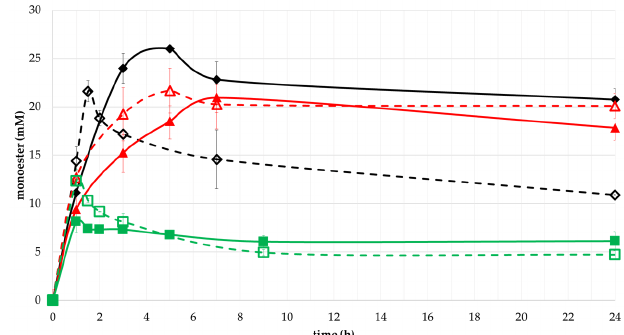
Figure 8. Time ‐ course of the monoester synthesis of lactulose by selected enzymes and effect of temperature in monoester production. Reaction conditions: 30 mM lactulose and 150 mM vinyl laurate, 25 mg/mL of biocatalyst, 2M2B (20% DMF). ― ― Novozym 435, 30 °C and ‐‐ ‐‐ 60 °C; ― ― Lipozyme from Mucor miehei , 30 °C and ‐ ‐ ‐ ‐ 60 °C, ― ― Lipozyme TL IM, 30 °C and ‐ ‐ ‐ ‐ 60 °C.